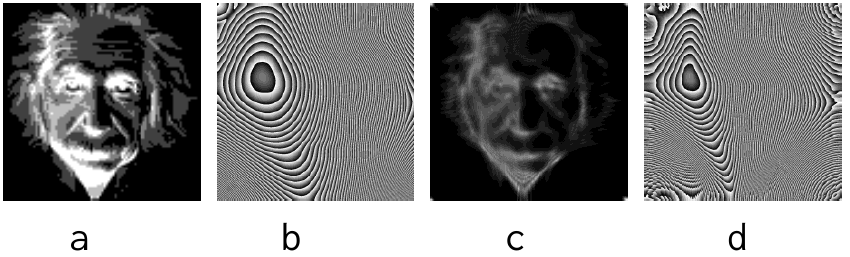
Figure 7. Example of a non-uniform irradiance mask design and its diffraction spectrum. ( a , b ) The original image and its phase-only hologram, respectively, and ( c , d ) the amplitude of the simulated diffraction pattern and its phase distribution, respectively.